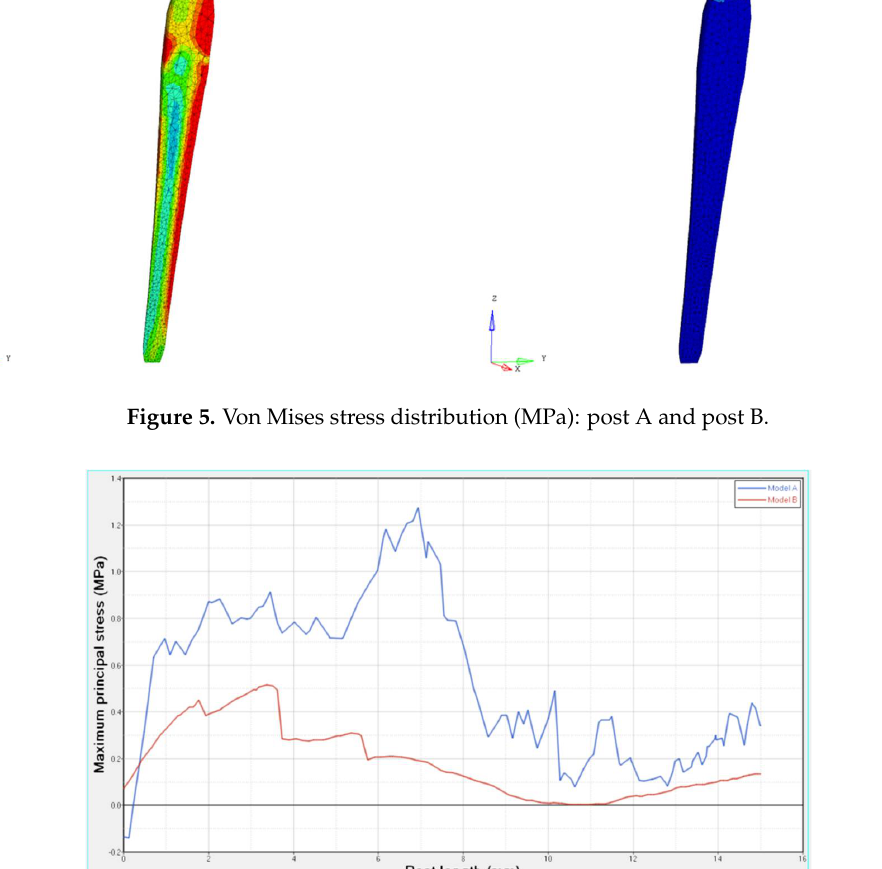
Figure 6. Maximum principal stress distribution along the center of the post from the coronal to the apical part.